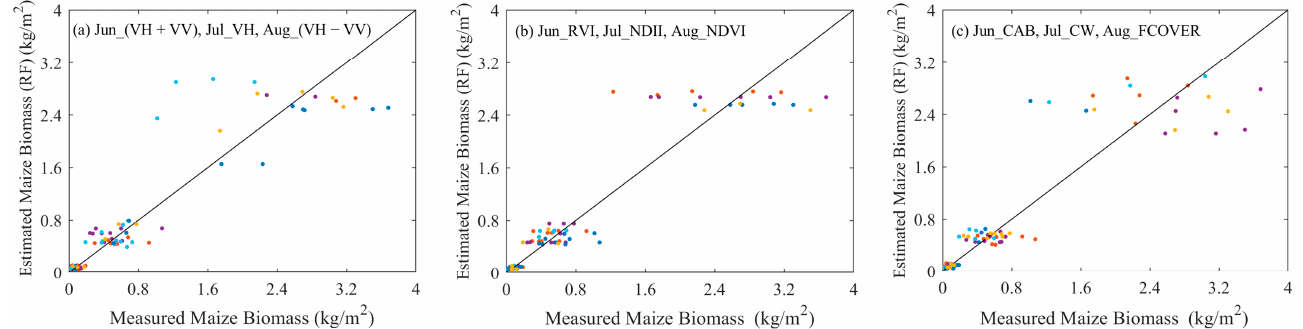
Figure 8. Measured vs. estimated biomass by RF with combined predictors. The different colors